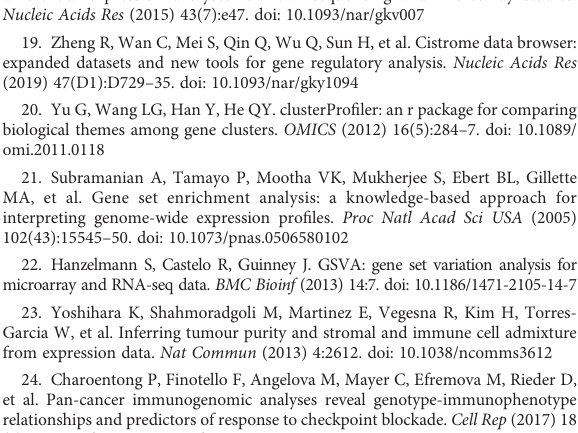
SUPPLEMENTARY FIGURE 1 Study design and fl owchart.